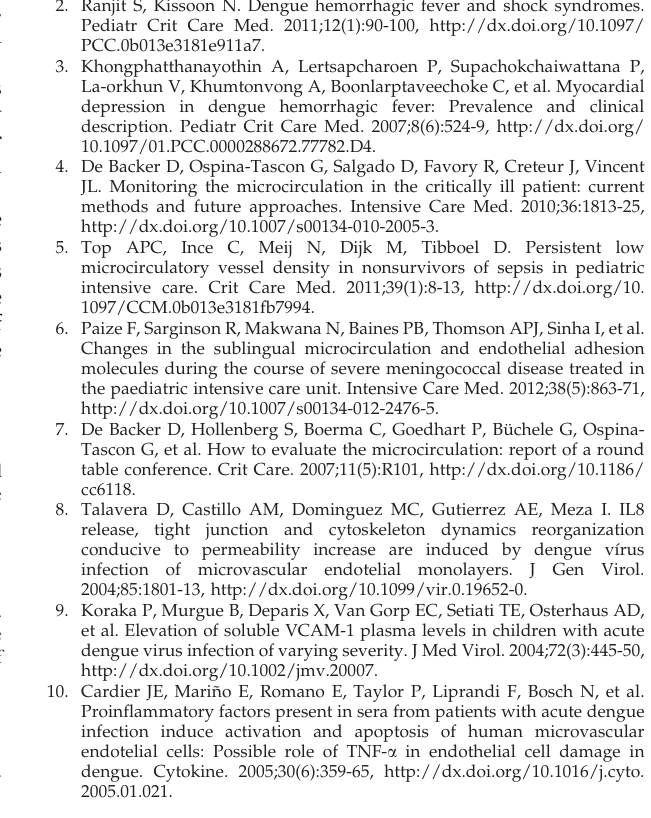
table conference. Crit Care. 2007;11(5):R101, http://dx.doi.org/10.1186/